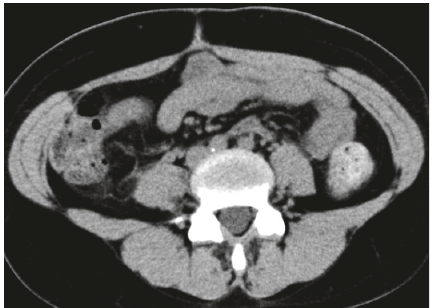
Figure 3: Abdominal plain CT scan one month after surgery. The retroperitoneal mass had